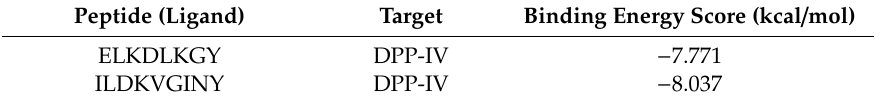
Table 2. Molecular docking score of peptides binding to target dipeptidyl peptidase-IV (DPP-IV).